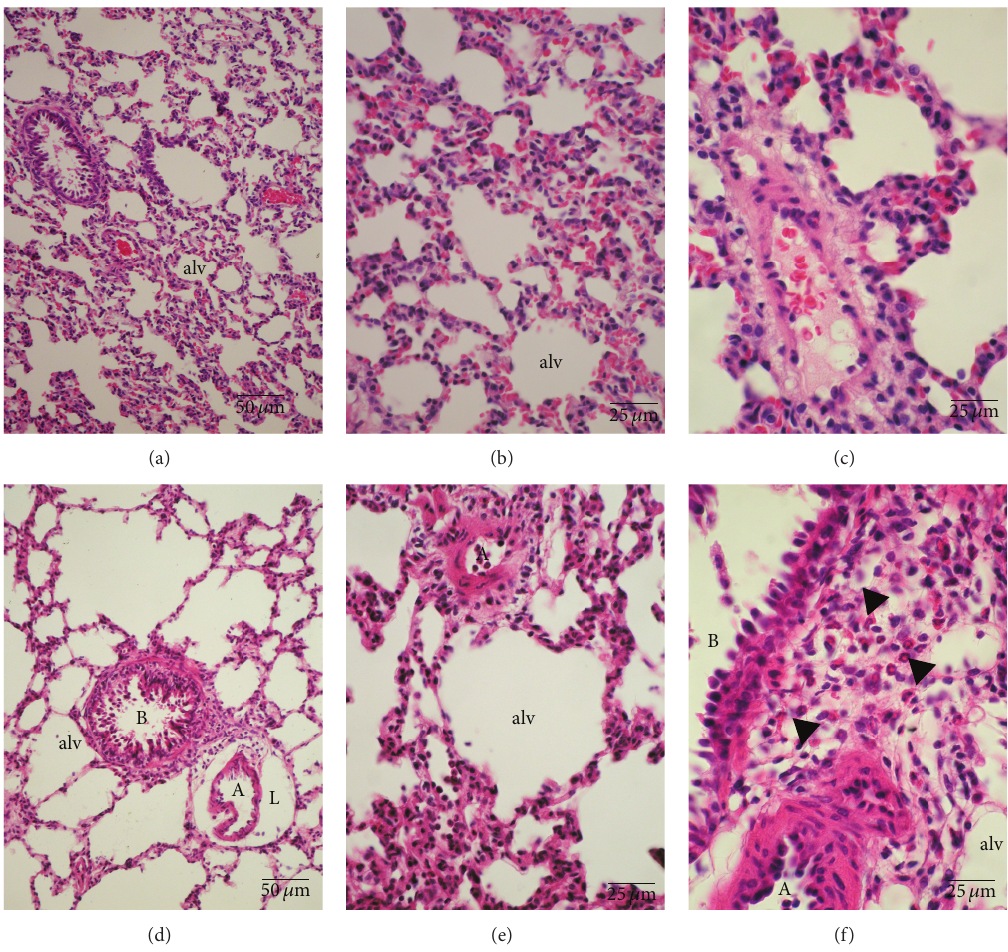
Figure 6: Representative sections of lung tissue from sham-operated animals (a, b, and c) and from animals submitted to hepatic ischemia/reperfusion (I/R) (d, e, and f). Hematoxylin and eosin staining. The sections from sham animals show the typical morphology of bronchi (B), blood vessels, and alveoli (alv) with associated capillaries; alveolar capillaries are recognizable in high magnification (c), by erythrocytes in the lumen. In the lung tissues of animals submitted to hepatic I/R alveoli appear to be dilated. (d, e) Dilated lymph vessels (L) surrounding arteries (A) and an abundant number of inflammatory cells (arrowheads) in the lumen and stroma of blood vessels